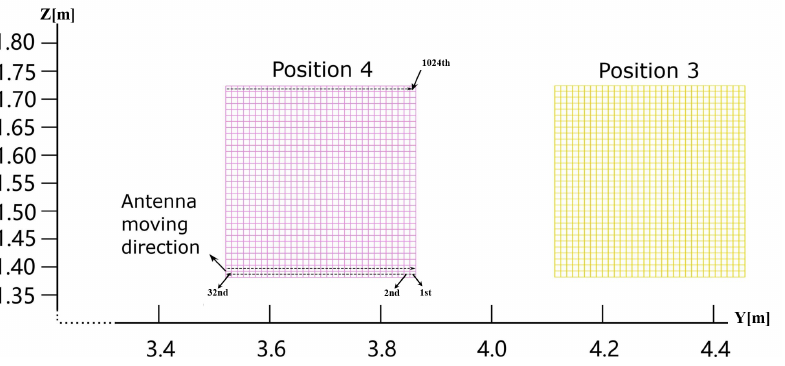
Figure 2. Movement of the virtual antenna